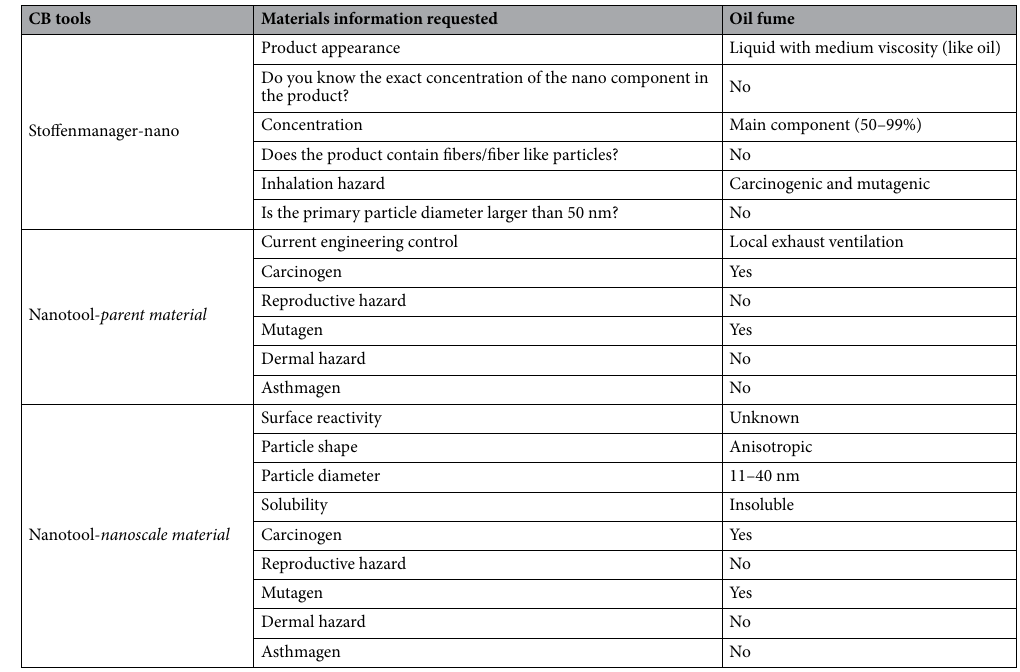
Table 2. Hazard input data of the evaluated materials required by different control banding (CB) tools.